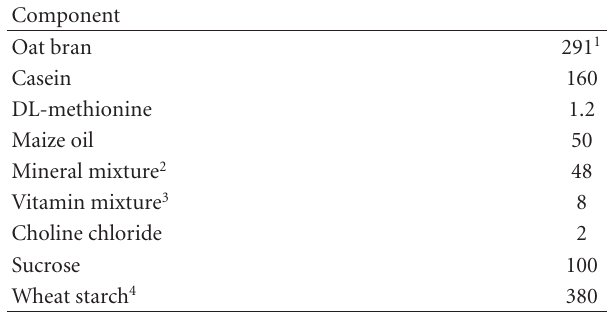
Table 1: Diet composition. Composition of test diets (g/kg dwb) given to rats in all groups (NC, DSS, and